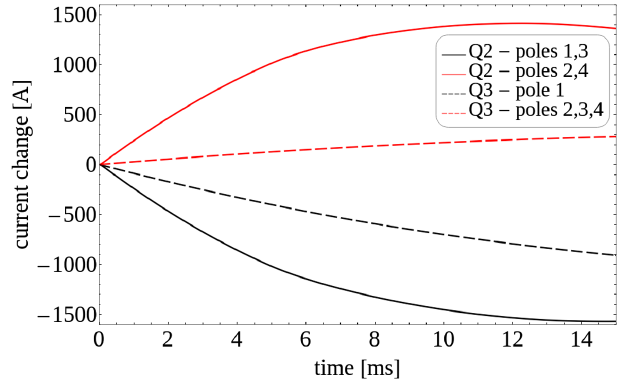
FIG. 8. The current induced by CLIQ into the Q2 and Q3 magnets (Q1 is equivalent to Q3). In Q2, the change is symmetric between the two pairs of poles, whereas in Q3, one pole sees a much larger decrease of the current than the increase in the other three poles.FIG. 7. The orbit excursion induced by a CLIQ discharge in the